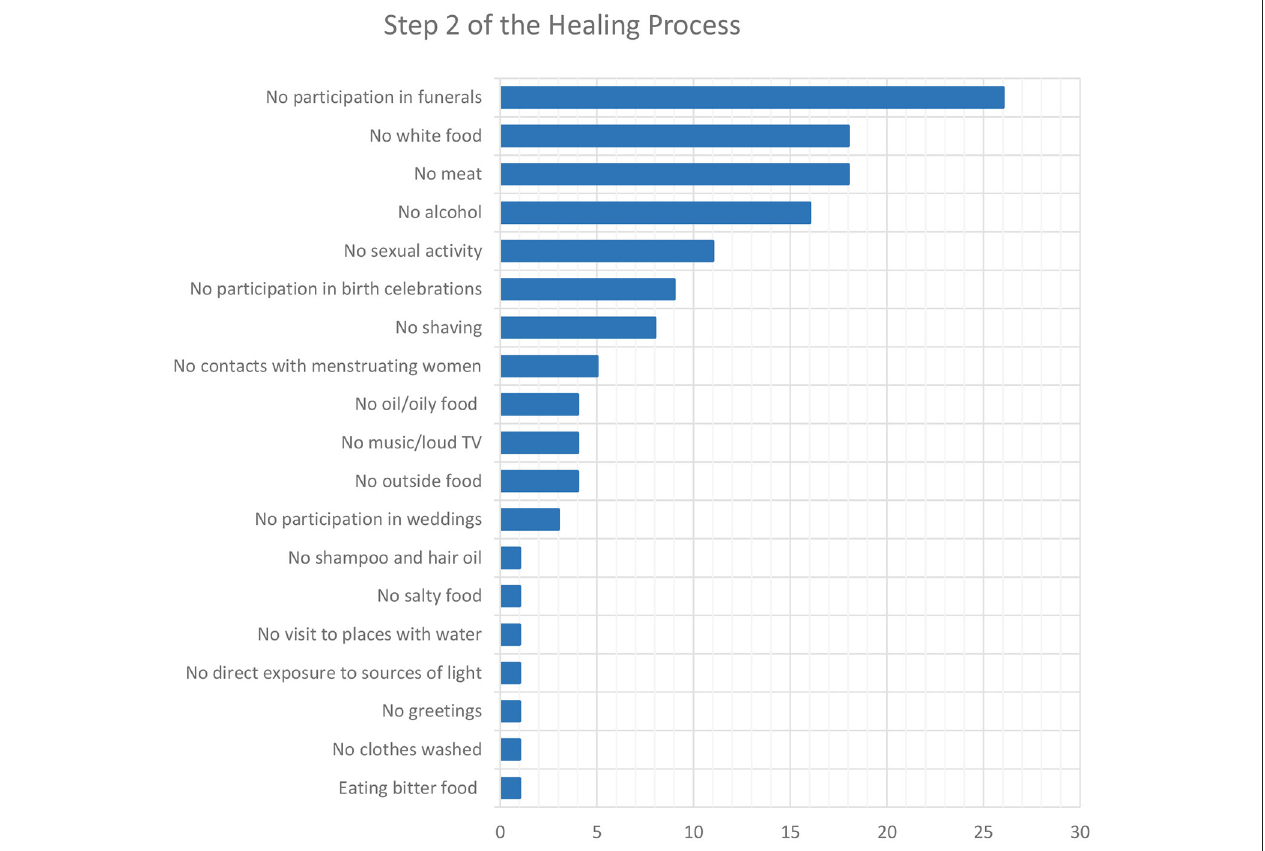
FIGURE 3 | Number of interviewees who mentioned the rules to follow during the second step of the healing process.